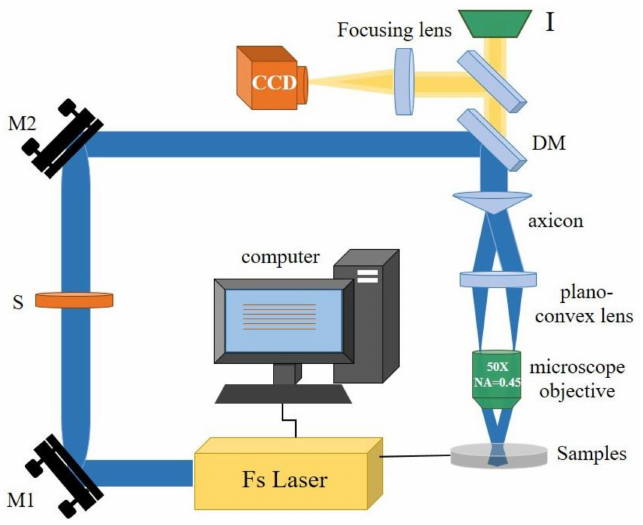
Figure 9. Experimental set-up of femtosecond laser Bessel beam processing